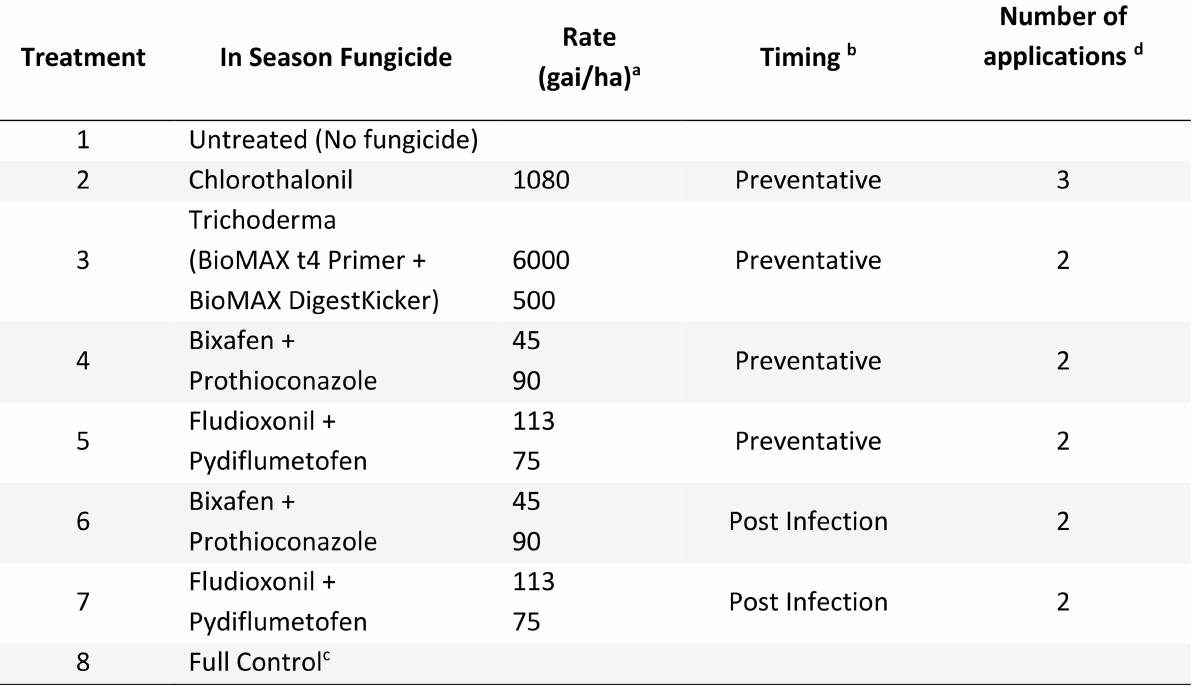
TABLE 3 Fungicide treatments and the number of applications applied for each treatment to assess control of Ascochyta blight (AB) in chickpea at Nhill during